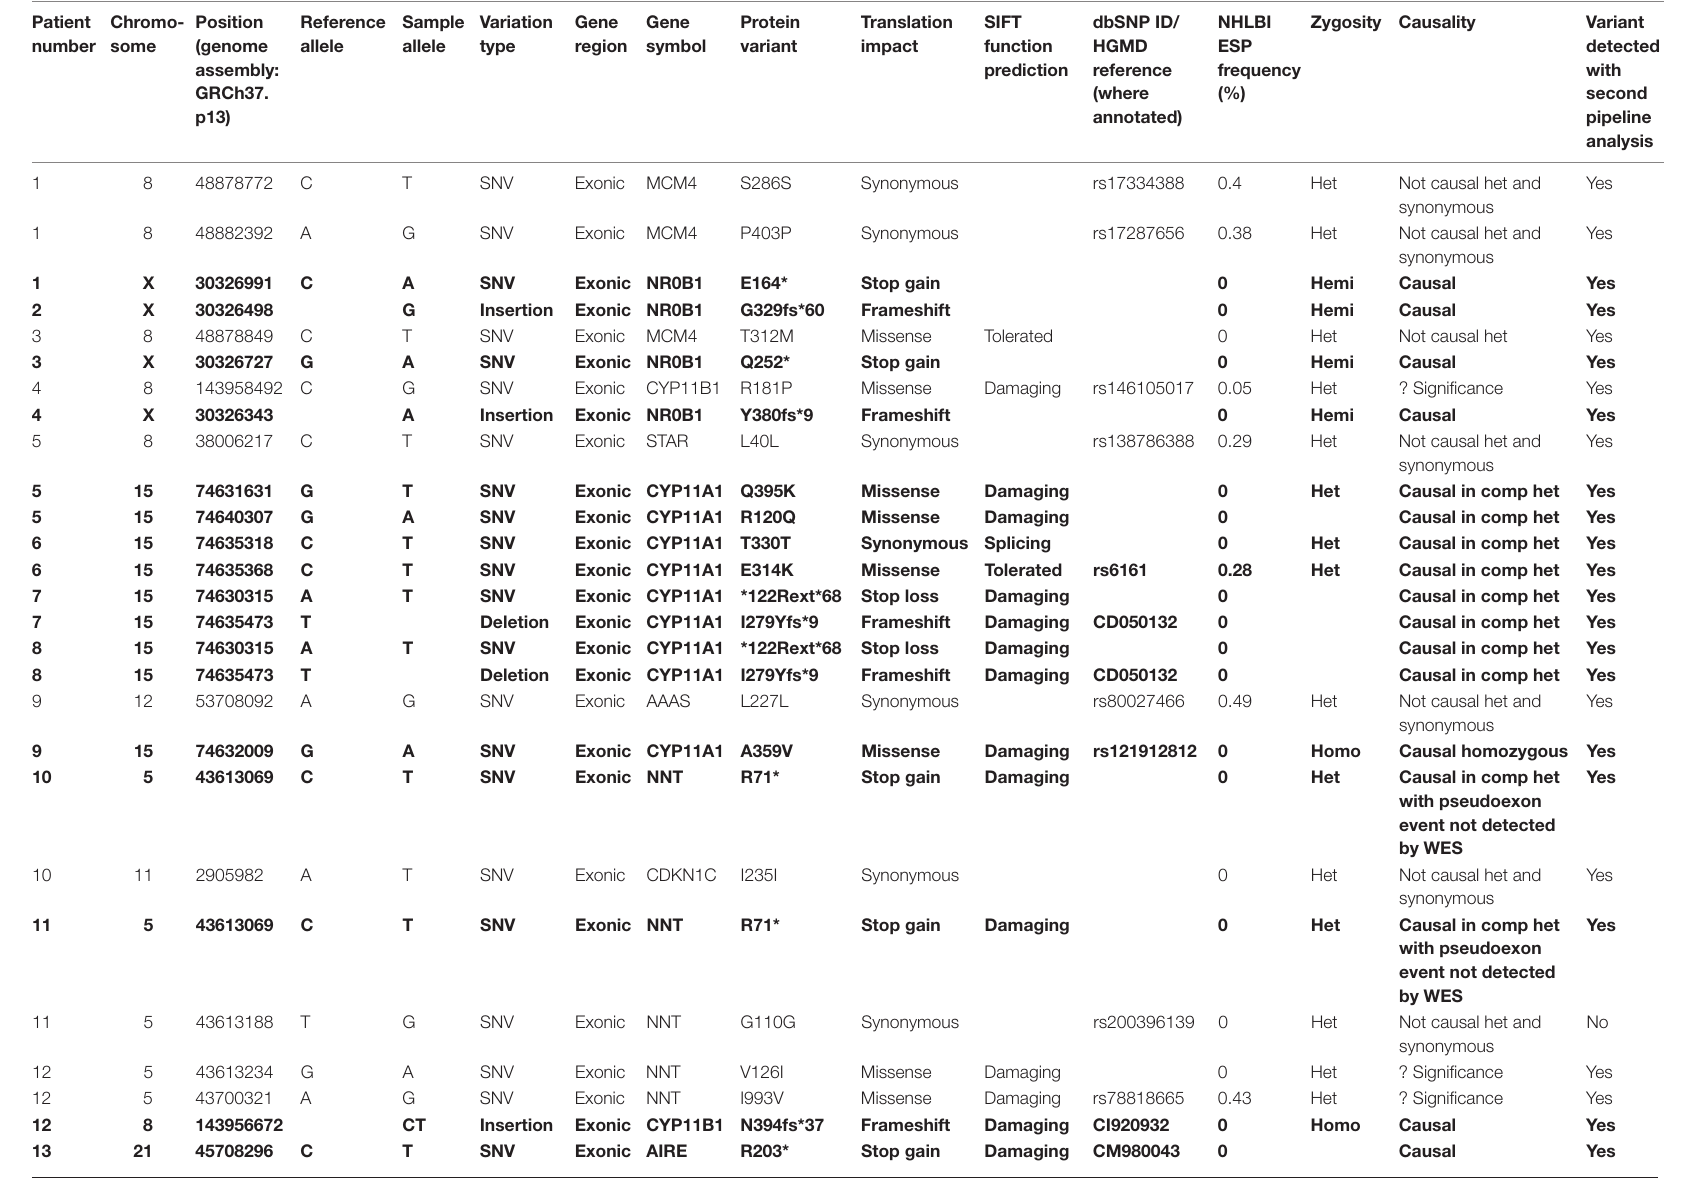
TaBle 3 | Variants, including synonymous changes, detected after ingenuity filtration screening of the 20 Pai causal genes listed in Table 1. Patient chromo- Position number some (genome assembly: